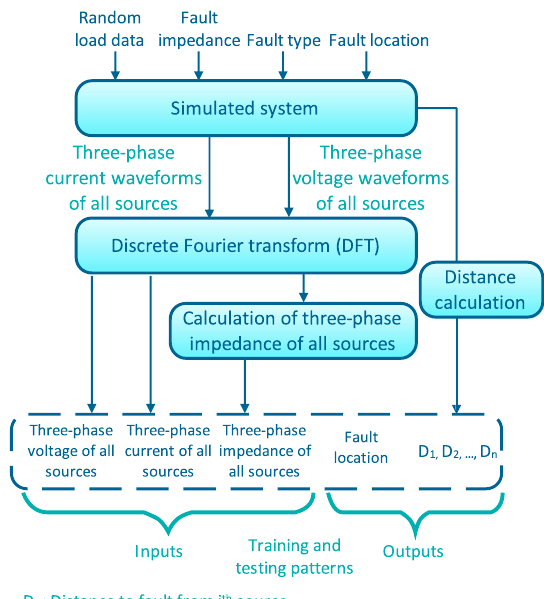
Fig. 4 Generation of training and testing data